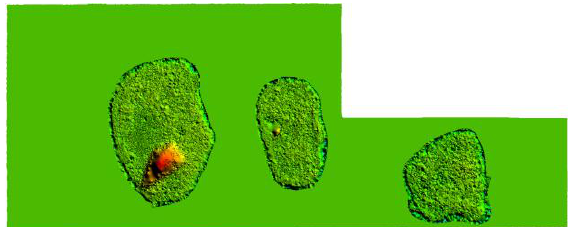
Figure 8. DEM from Multitemporal Stereo Satellite Imageries The results showed that there were differences high value between multitemporal stereo satellite imageries and Indonesia geoid model. Difference of high value in the range of 0.2 to 2.1m. Magnitude the difference between the average high is 1.06m. Table 2 presents all the results of the difference high value between multitemporal stereo satellite imageries and Indonesia geoid model.